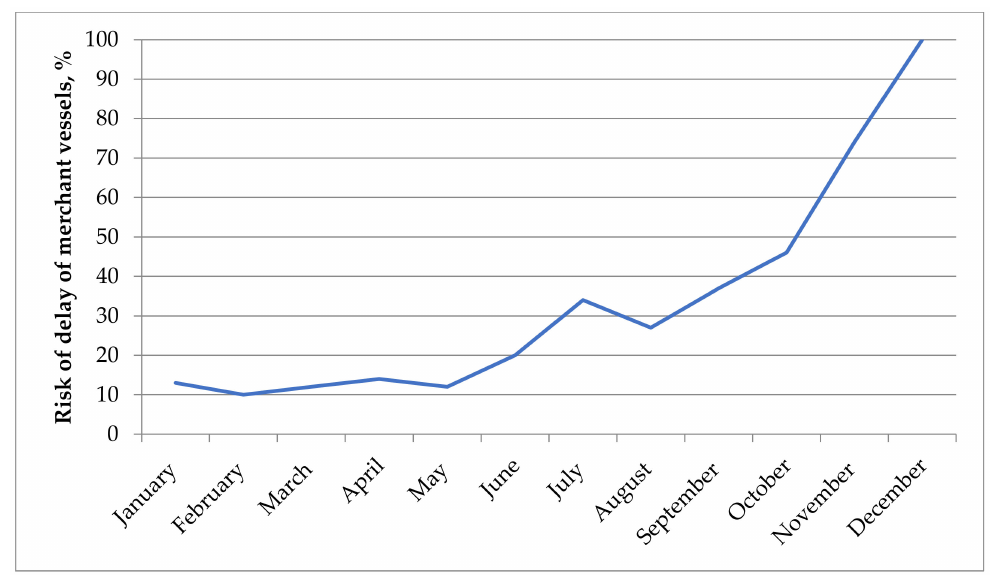
Figure 3. The risk of delay by warships of the aggressor of merchant ships that in 2018 were headed to the port of Mariupol (or departed from it) for a period of 10 h or more, percentages. The value of the first derivative of this risk in time ( ∂ϕ the angle of inclination of each individual graph